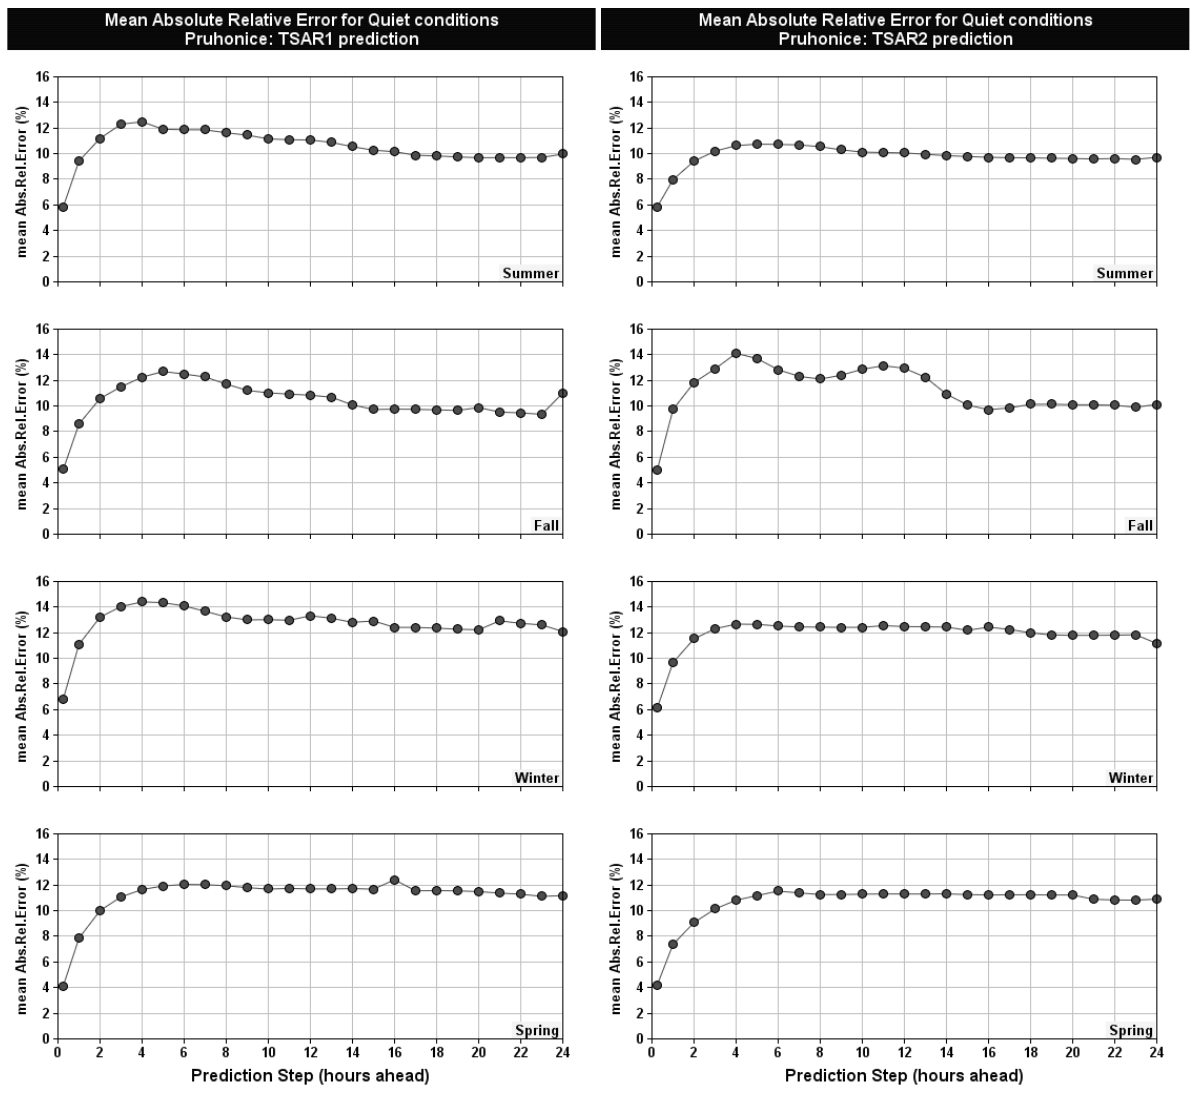
Fig. 10. The same as Fig. 9 for